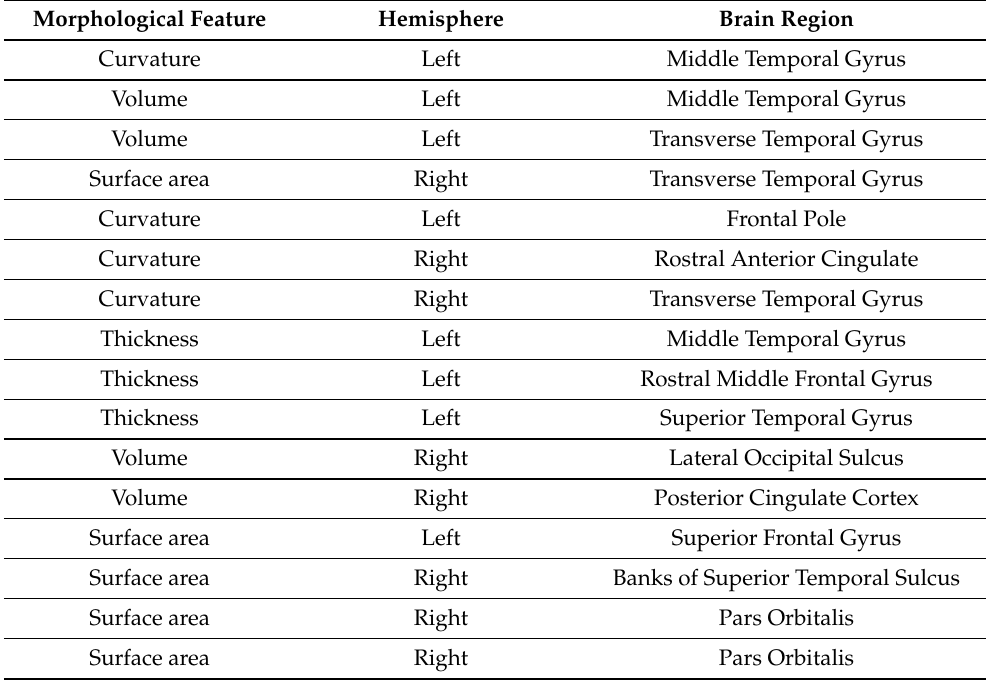
Figure 10. Visualization of the most frequent brain regions to be selected by RFECV+LG2. Table 5. The most frequent morphological features and brain regions to be selected by RFECV+lg2 discriminative